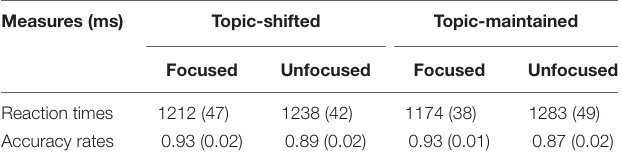
TABLE 4 | Results for the probe-recognition task in Experiment 2 (with standard errors in parentheses). Measures